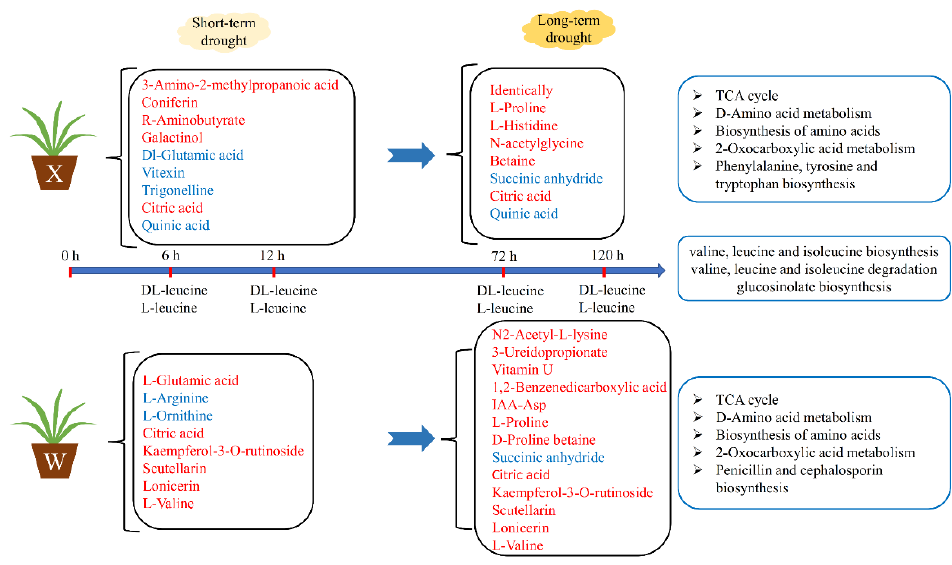
Figure 9. Patterns of response to drought stress in drought resistant and drought sensitive genotypes of E. sibiricus . The red font indicates increased, while the blue font indicates decreased.